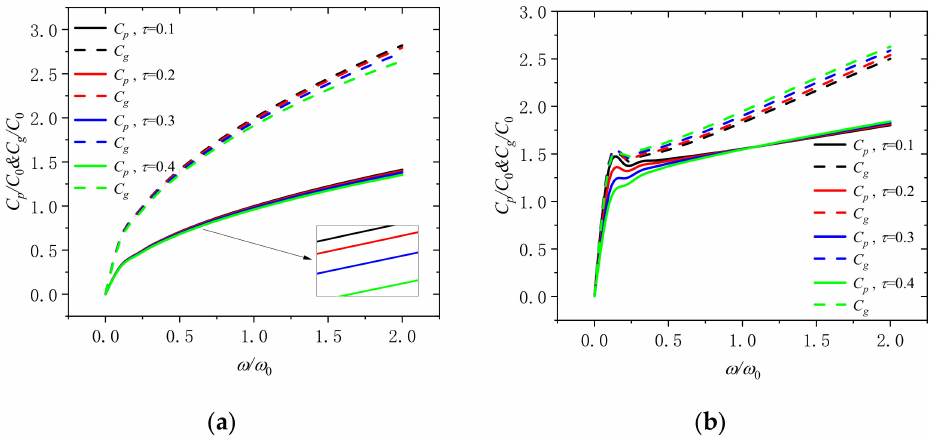
Figure 12. Phase speed and group speed in a rotating microbeam with different nonlocal scales ( τ = 0.1, 0.2, 0.3, and 0.4) for ( a ) Ω / Ω 0 = 0 and ( b ) Ω / Ω 0 =